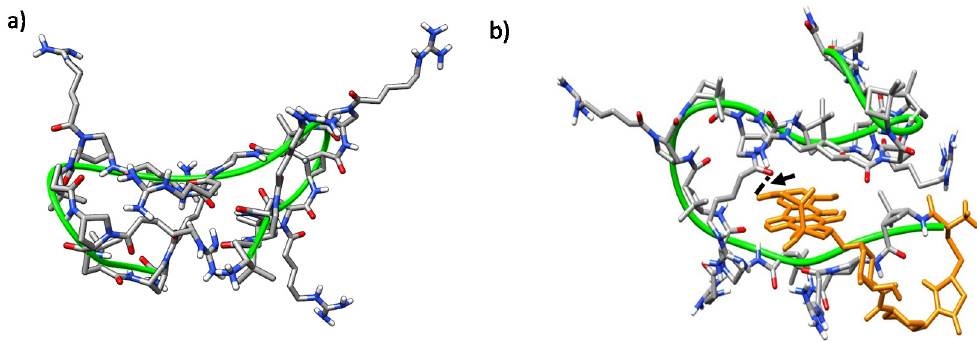
Figure 10. Representative MD conformations for ( a ) peptide γ -CC 5 and ( b ) conjugate ( R )-Dox- γ -CC, ( R )- 15 . The peptide sca ff old is highlighted by the green ribbon; Dox is represented in orange; the arrow points out long-range hydrogen-bonding between the primary hydroxyl group of the cyclohexane side-chain in Dox moiety and the N α -side chain C O in proline residue i = 8.